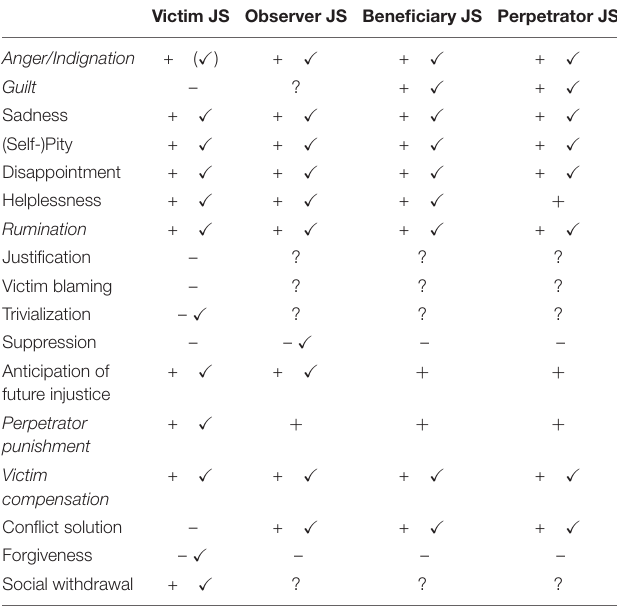
TABLE 1 | Expected direction of effects of JS facets on responses to unjust situations from the corresponding perspective and indication of supported